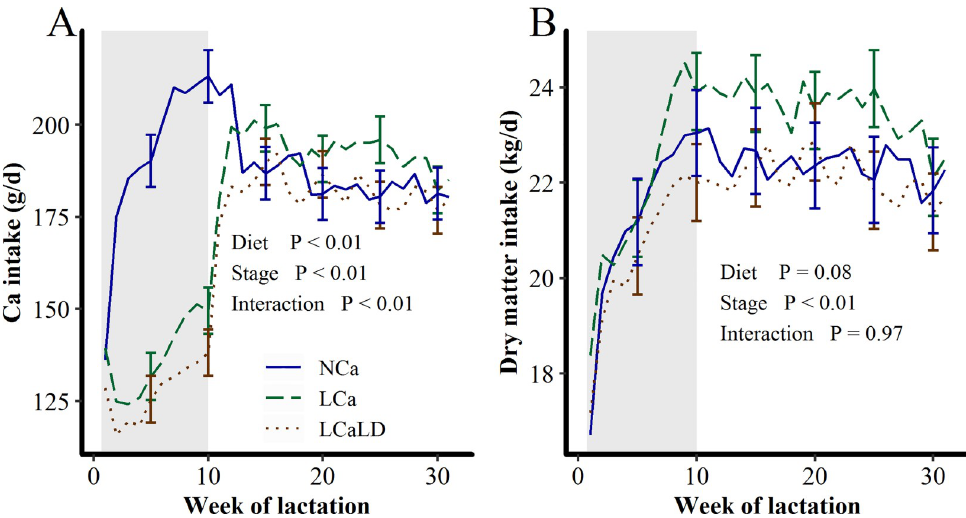
Fig 2. Effect of transient variation in dietary Ca content and the DCAD on A) Ca intake and B) dry matter intake between calving and 32 weeks of lactation . NCa = normal Ca (4 cows), LCa = low Ca (5 cows), LCaLD = low Ca and low DCAD (5 cows). Gray background specifies the period during which cows were fed differentiated diets according to the treatments. Data were analyzed using a generalized linear mixed model with repeated values using PROC GLIMMIX in SAS [35]. Covariance matrix: SP for Ca intake and dry matter intake. Vertical bars represent standard errors of the mean. Standard errors are shown every 5 weeks for readability.